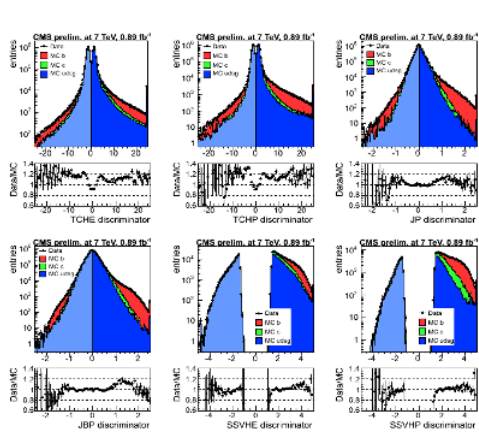
Fig. 4. Discriminators for: Top left Track Counting High E ffi - ciency (IP / σ (IP)), center Track Counting High purity (IP / σ (IP)), ri g ht JetProbability, Bottom left JetBProbability, center Simple Secondary Vertex High e ffi ciency, ri g ht Simple Secondary Vertex High